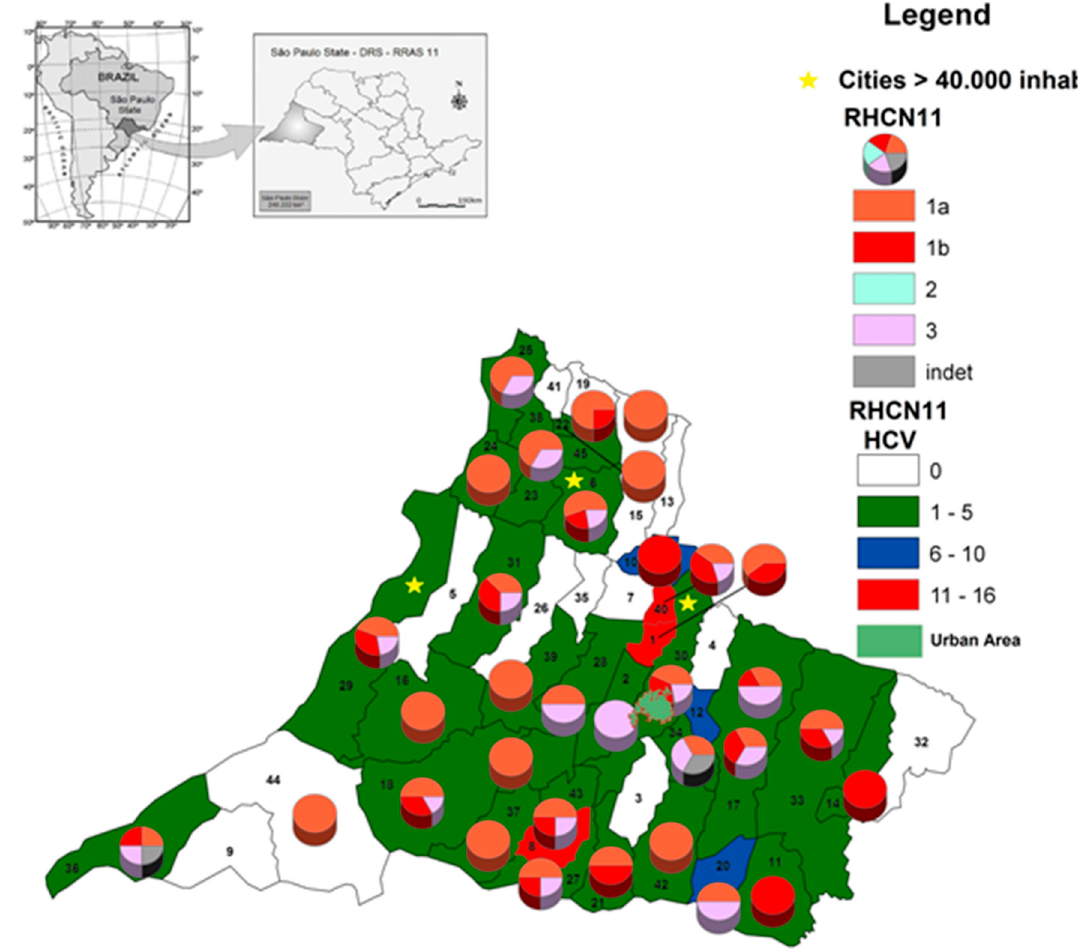
Figure 4. Geographic distribution of HCV and genotypes of patients diagnosed and treated between 2015 and 2018, according to the municipality of residence in RHAN11 mesoregion, western S ã o Paulo, Brazil. The colors represent the cumulative number of cases. The municipalities are numbered in alphabetic